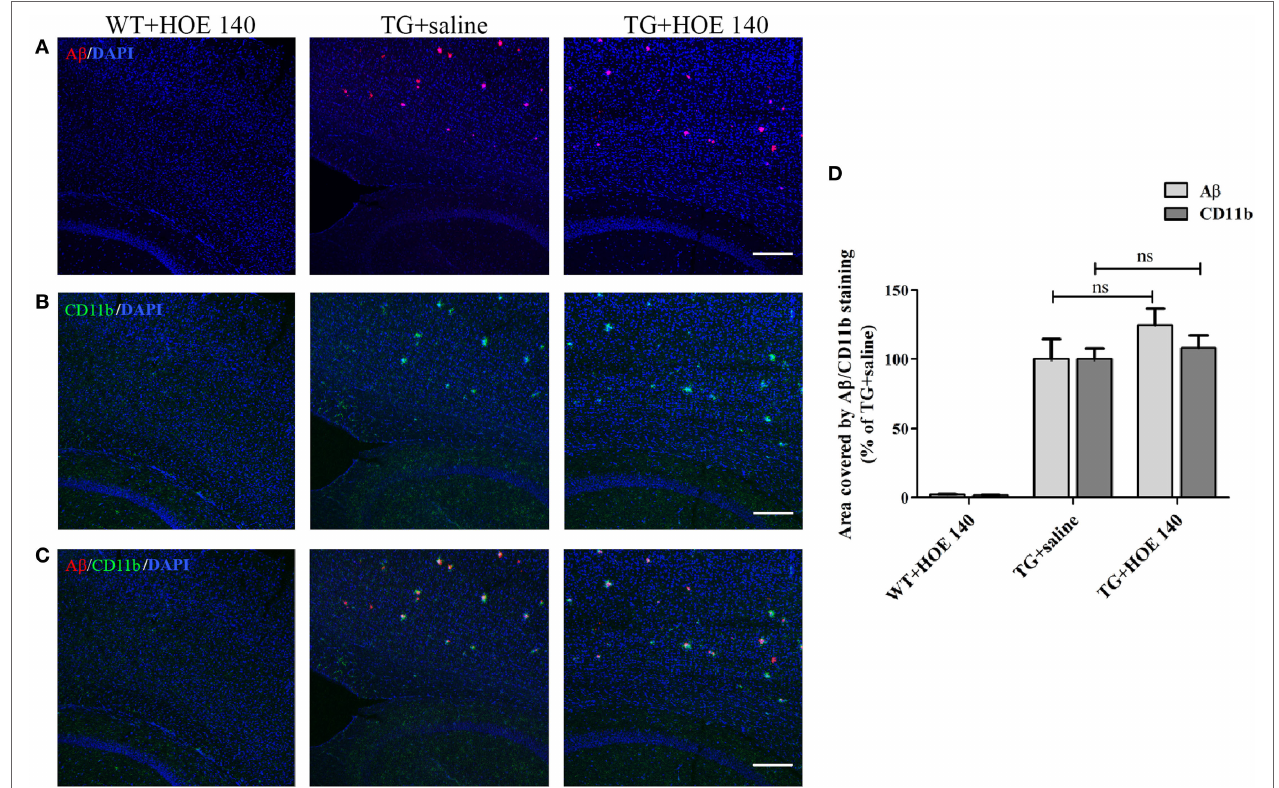
FigUre 6 | The effects of intranasal delivery of the bradykinin B 2 receptor antagonist on amyloid burden and the accumulation of microglial cells in the cortex of 5X familial aD (5XFaD) mice . Two-month-old mice were treated with HOE 140 or the vehicle for 3½ weeks. After cardiac perfusion, their brains were cut into sections, stained for A β ( red ) (a) and CD11b ( green ) (B) using appropriate antibodies and counter-stained with DAPI ( blue ). Representative confocal images of cortical sections from wild-type (WT) or 5XFAD mice (TG) are shown. (c) Merged images of A β and CD11b staining. The dose of intranasally administered HOE 140 was 1 mg/kg/day. Each group included 4–7 mice ( n = 15–19 per experiment). The stained areas were quantified. The mean ± SEM of percentage of the stained areas is shown in the graphs, n ≥ 3 determinants (D) . For statistical comparisons, a one-way analysis of variance and Tukey–Kramer Multiple Comparison Test were conducted. ns, non-significant. The scale bar is 200